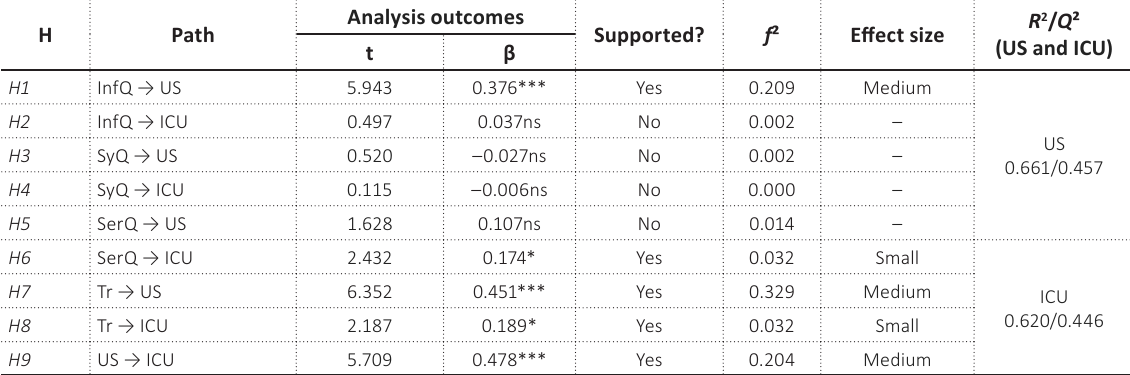
Table 4. Structural model